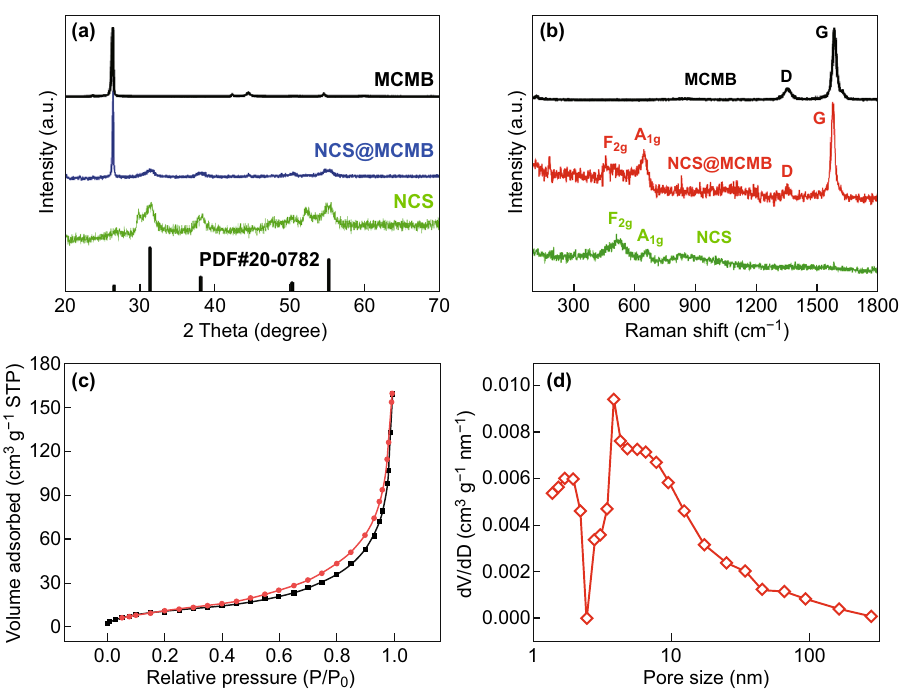
Fig. 4 a XRD patterns and b Raman spectra of pure MCMB, NCS@MCMB, and pure NCS. c Nitrogen adsorption/desorption isotherm and d pore size distribution of NCS@MCMB